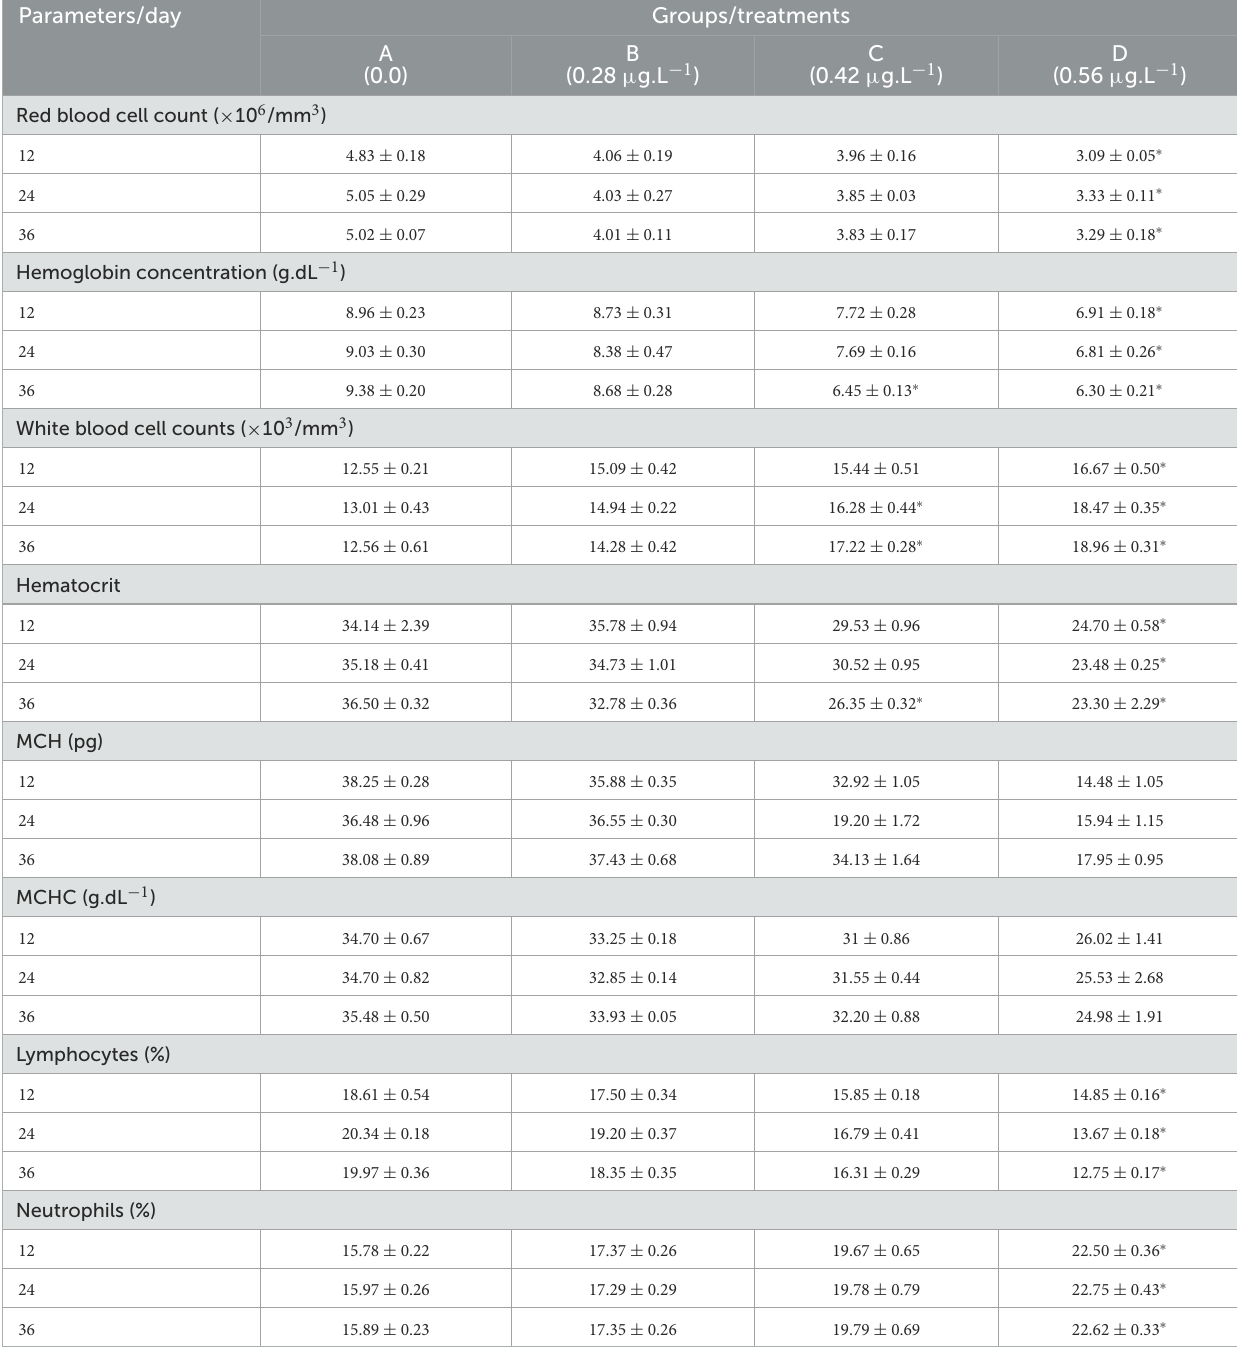
TABLE 4 Hematology of fish treated with various concentrations of copper sulfate. Parameters/day